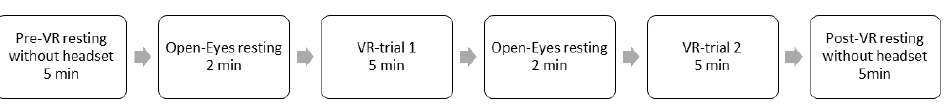
Figure 9. Six segments of the whole EEG data